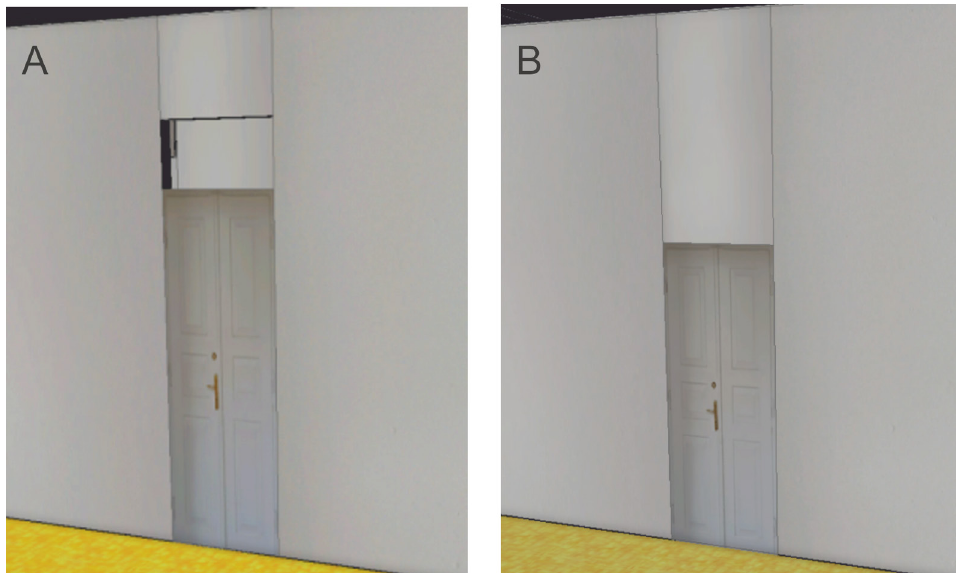
Fig. 2. Correction of the door height: A) before the change, B) after the